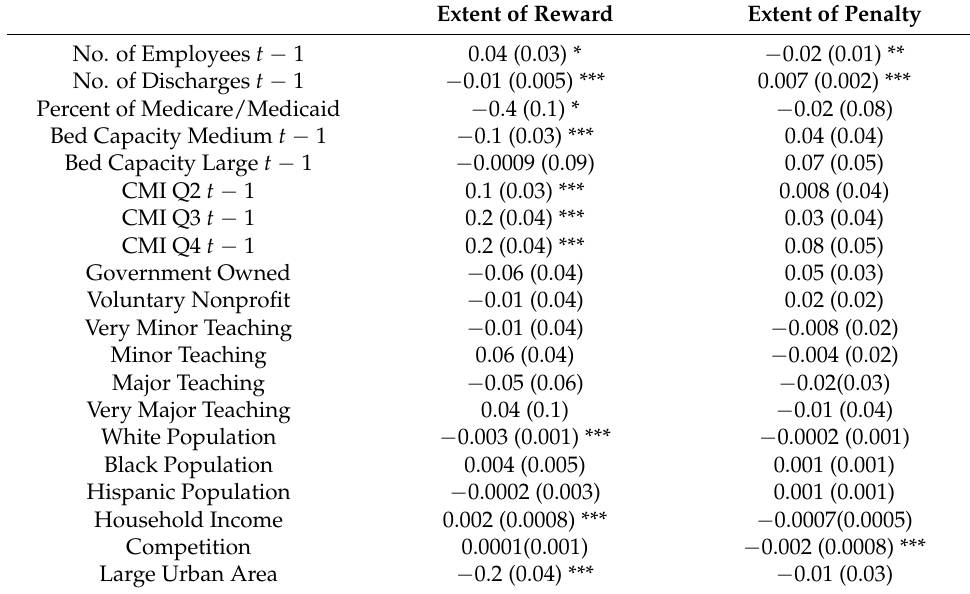
Table 10. Estimation of effects of factors on extent of